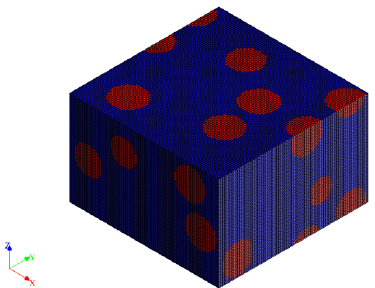
Figure 3. Simulated RVEs for 9.5. vol% Cu-PU composite for several applied pressures on the poly-